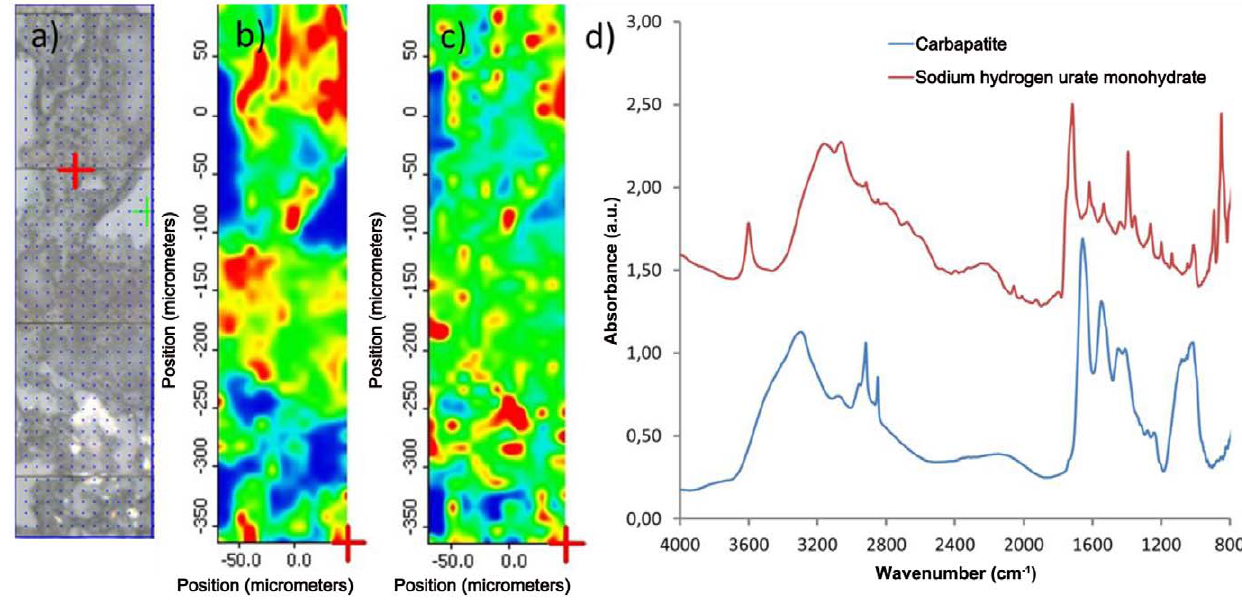
Figure 2. Optical image and mapping of BR165 biopsy (scale from blue to red with increasing concentration), and FT-IR spectra of crystals. a) Optical image of BR165, b) carbapatite map (done at 1030 cm -1 ), c) sodium hydrogen urate monohydrate map (done at 3600 cm -1 ), d) FT-IR spectra of those compounds.